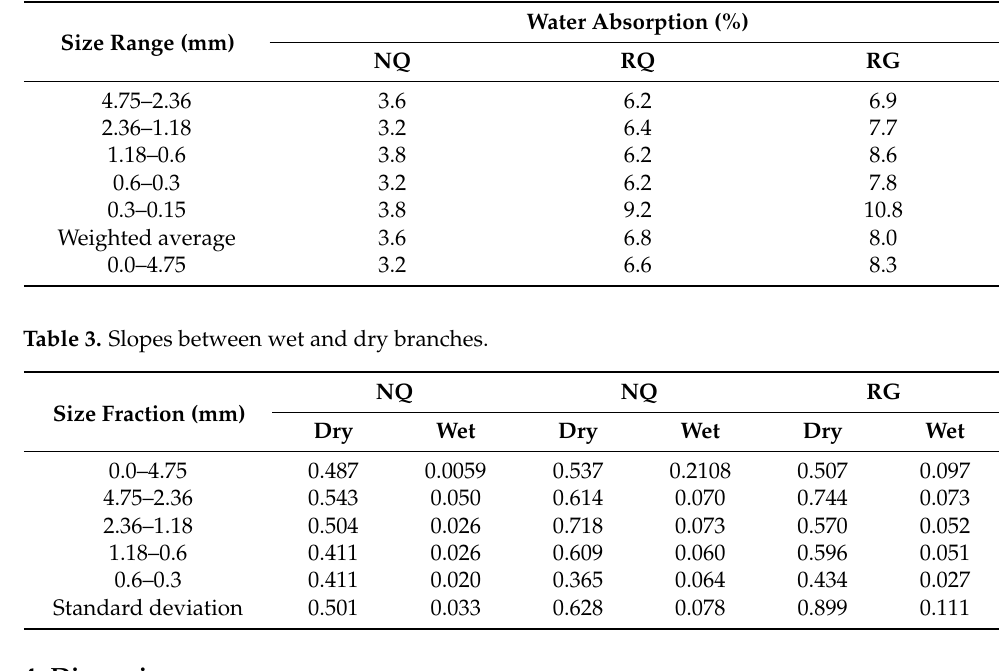
Figure 6. Cumulative frequency of R 2 values.